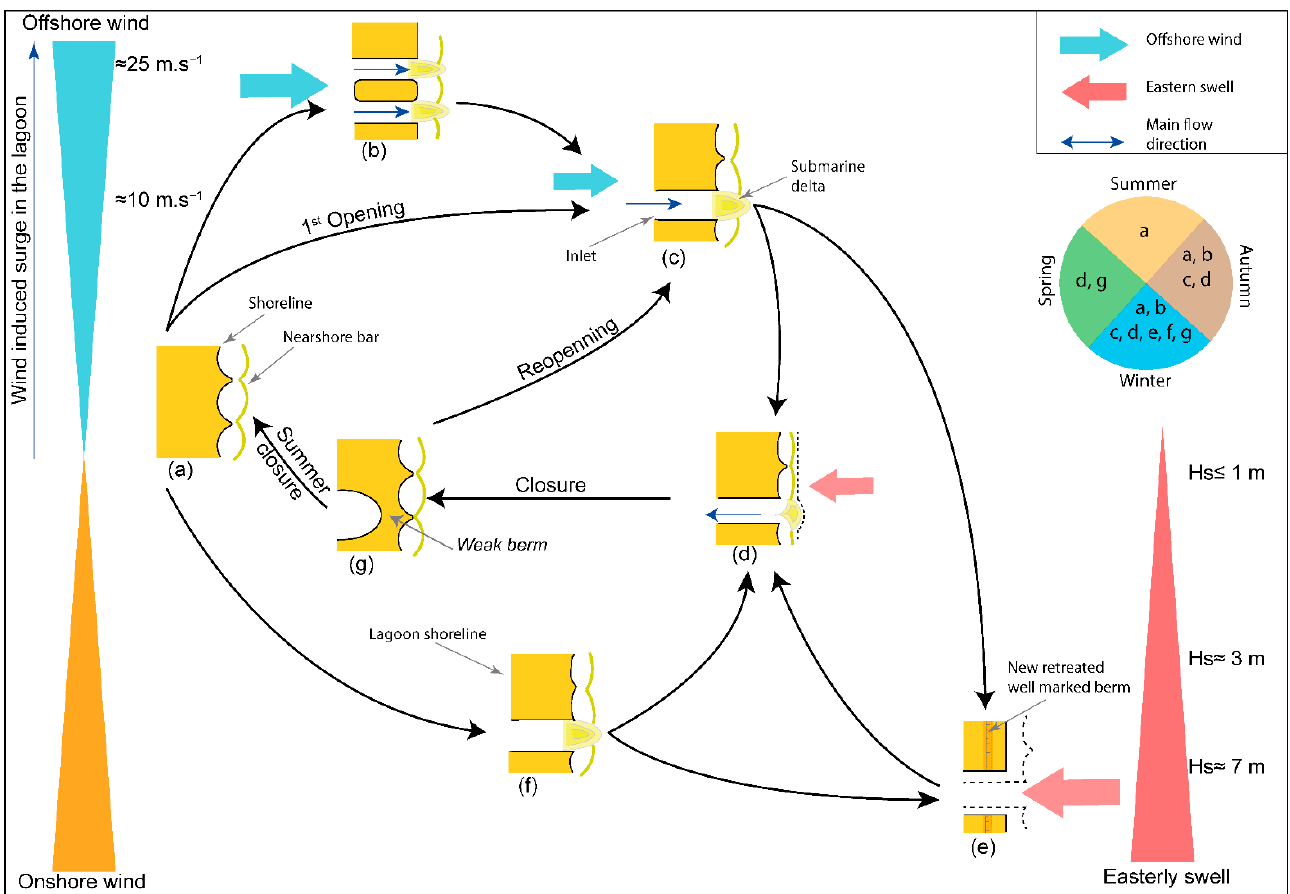
Figure 11. Morphodynamic model of an intermittent microtidal inlet. The evolution of the inlet is shown in relation to the dominant forcing, with offshore processes upward and onshore downward. The pie chart shows the most common periods for each of the situations. ( a ) the state of the beach at the end of the summer period; opening by offshore wind ( b , c ); ( f ) opening following a storm event and ( e ) impact of a storm on an already open inlet. Wave closure mechanism ( d , g